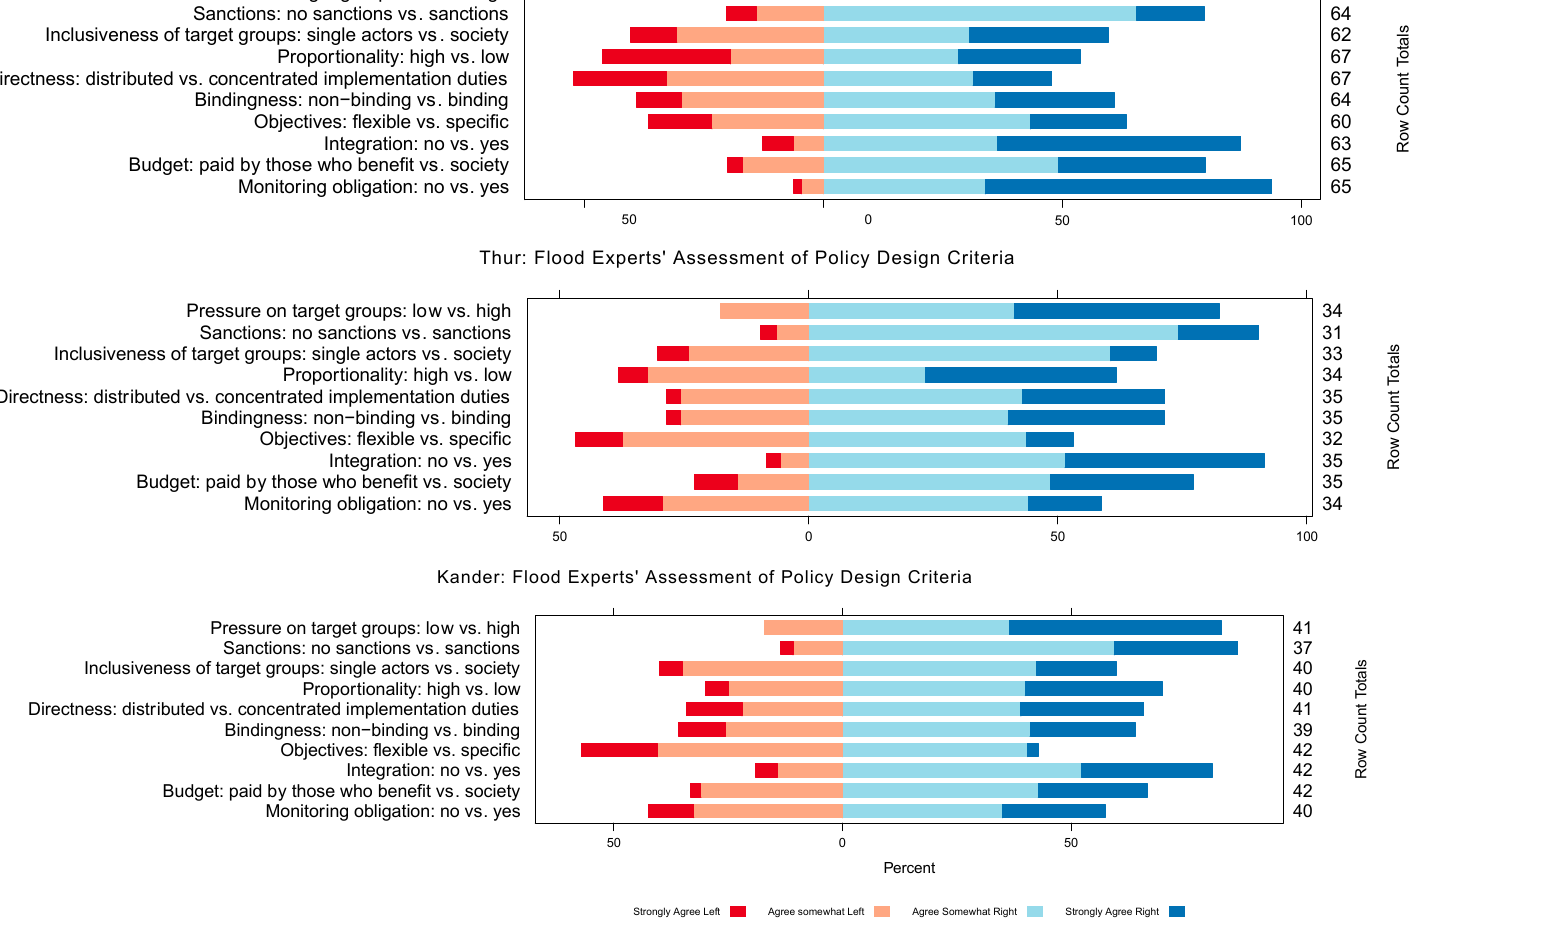
Figure 3. Flood experts’ assessment of policy design indicators.